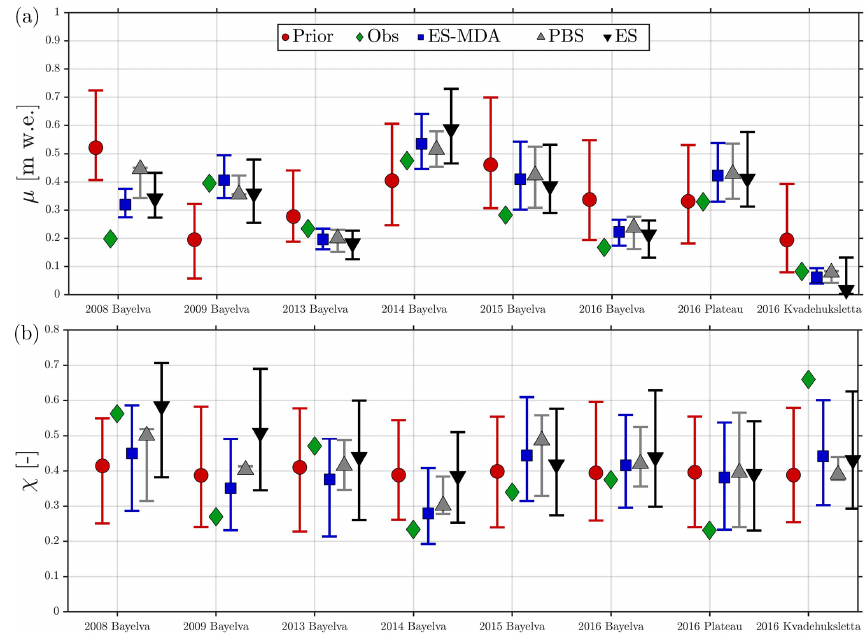
Figure 7. Prior median, observed, ES-MDA (with N a = 4), PBS and ES posterior median peak mean SWE µ (a) and peak subgrid coefficient of variation χ (b) ; error bars: 90th-percentile range; all DA schemes were run with 10 2 ensemble members. These results are from a single